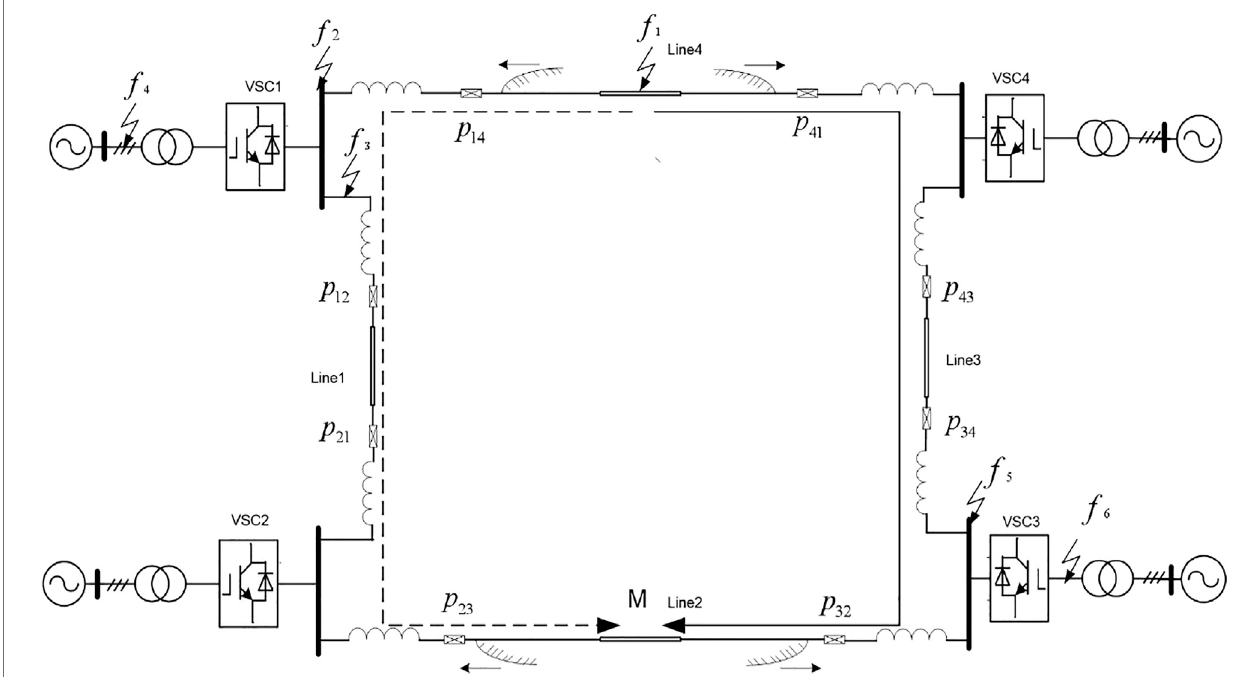
FIGURE 1 | Schematic diagram of structural line failure of four-terminal fl exible DC